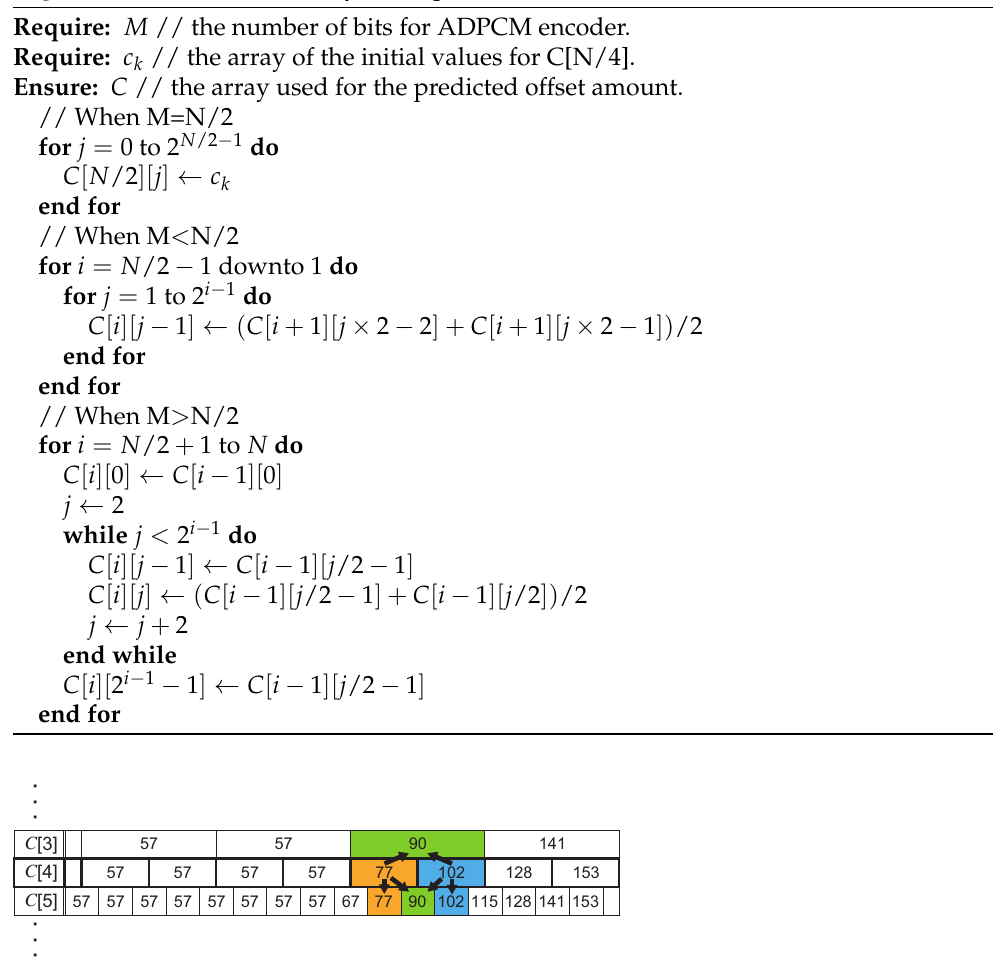
Algorithm 3 Initialize the array of the predicted offsets.